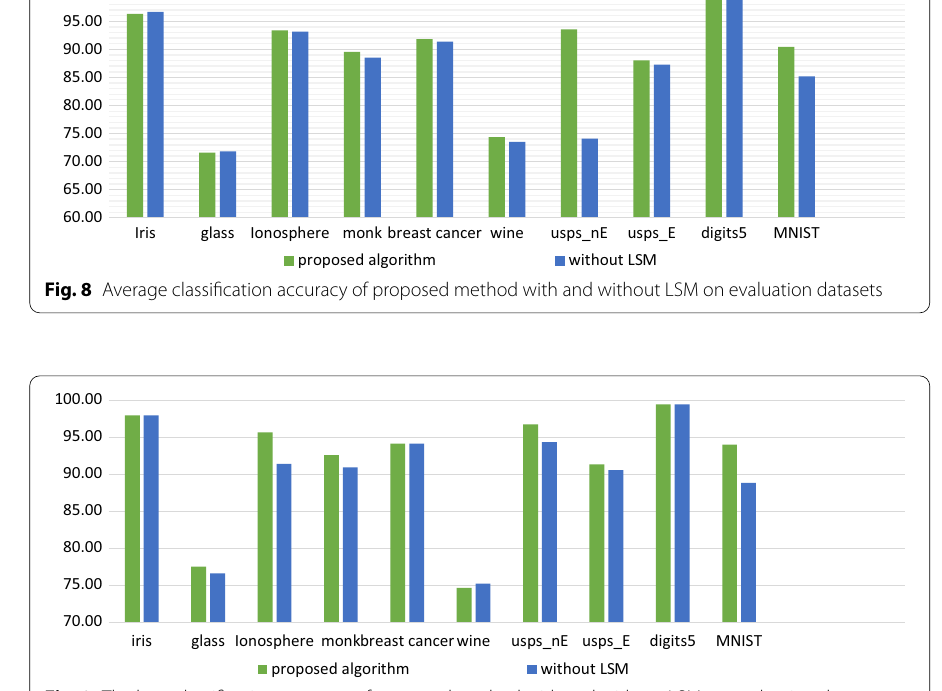
Fig. 9 The best classification accuracy of proposed method with and without LSM on evaluation